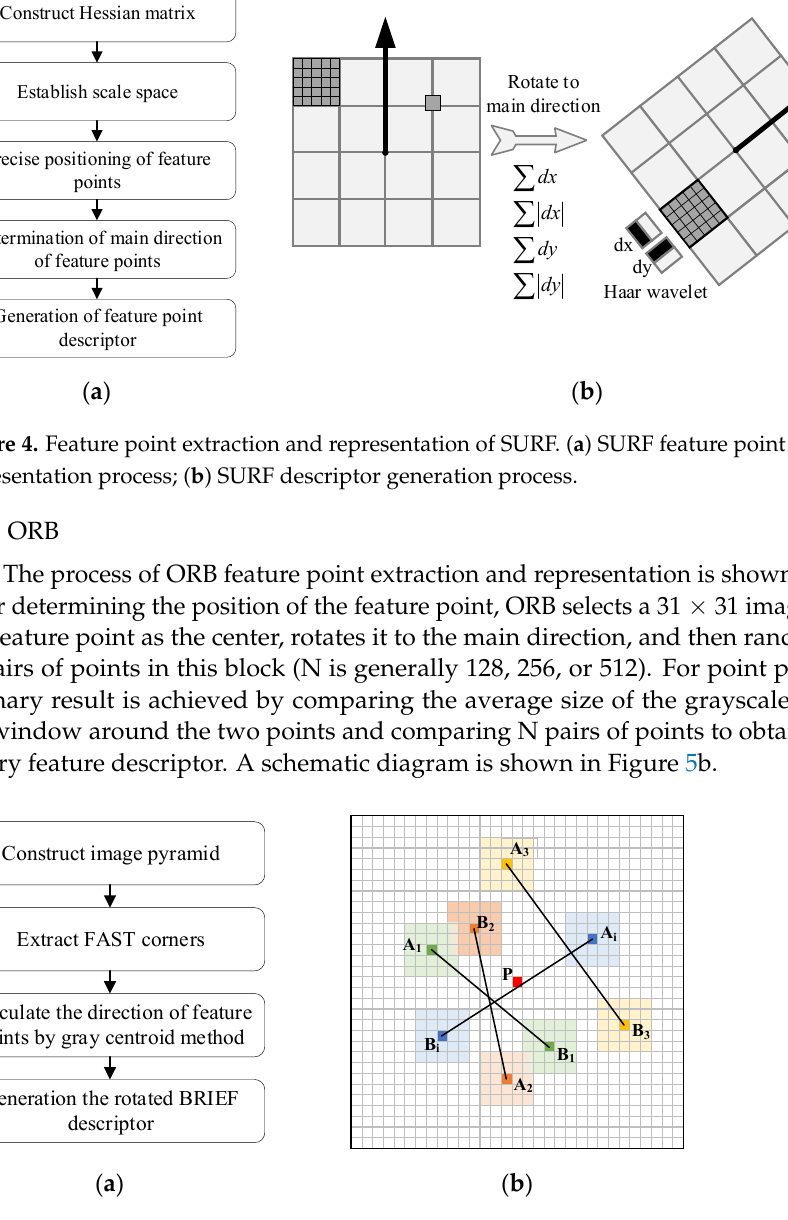
Figure 5. Feature point extraction and representation of ORB. ( a ) ORB feature point extraction and representation process; ( b ) schematic diagram of the rotated BRIEF descriptor generation.